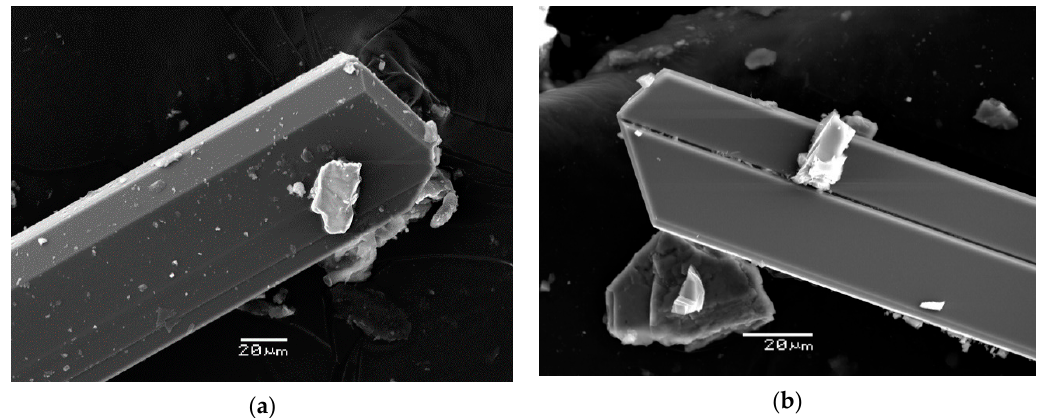
Figure 1. Crystal of shuiskite-(Cr) ( a ) and a twin with a (001) composition plane ( b ). SEM (SE) images. Shuiskite-(Cr) occurs together with pink Cr-bearing clinochlore and bright green uvarovite on the walls of 0.5 to 1 cm thick fractures in chromitite, filled with colourless